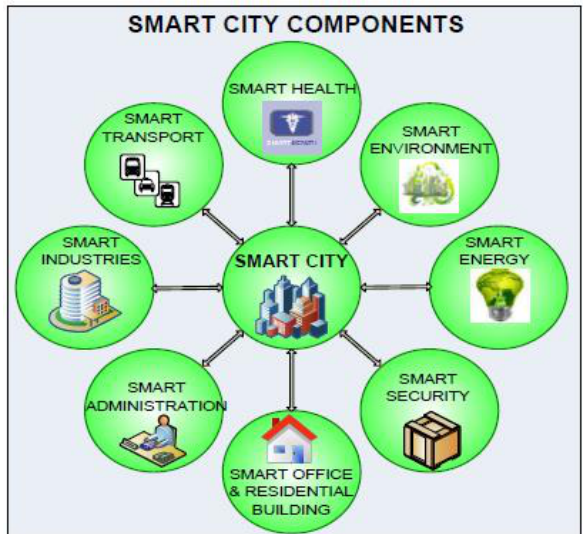
Figure 1. Smart City Components (Gaur et al. 2015)